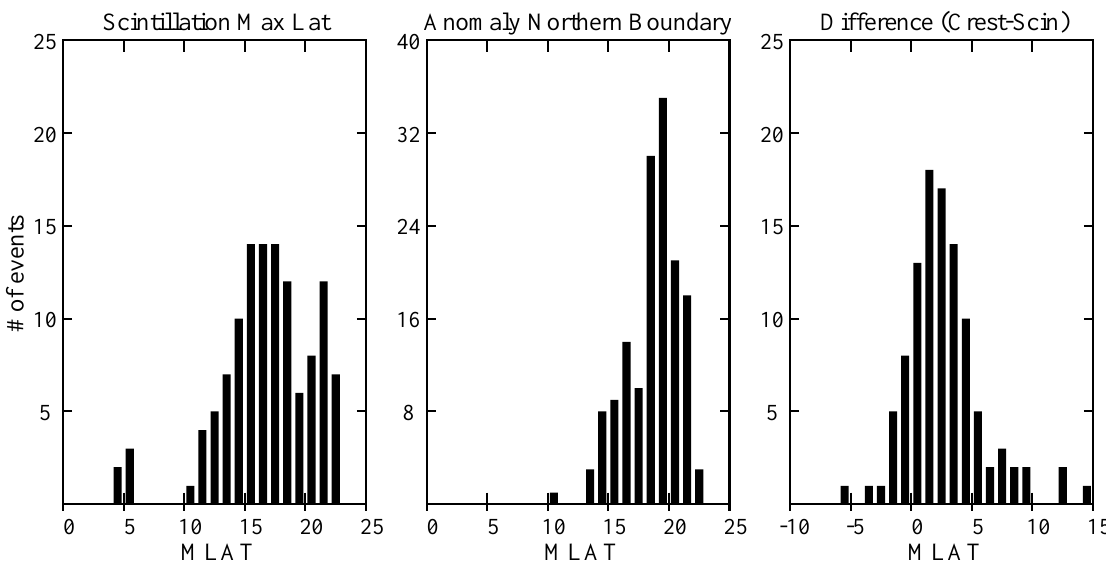
Fig. 9. The left histogram shows the maximum latitude of scintillations. The center panel displays the location of the northern boundary of the anomaly, defined as the poleward edge where the northern crest decreases 50% of its peak value. The right panel exhibits the distribution of the difference between poleward boundary of the anomaly and the maximum latitude of scintillations. Only in 9 cases out of 100 were GPS scintillations (and TEC depletions) seen poleward of the northern boundary of the